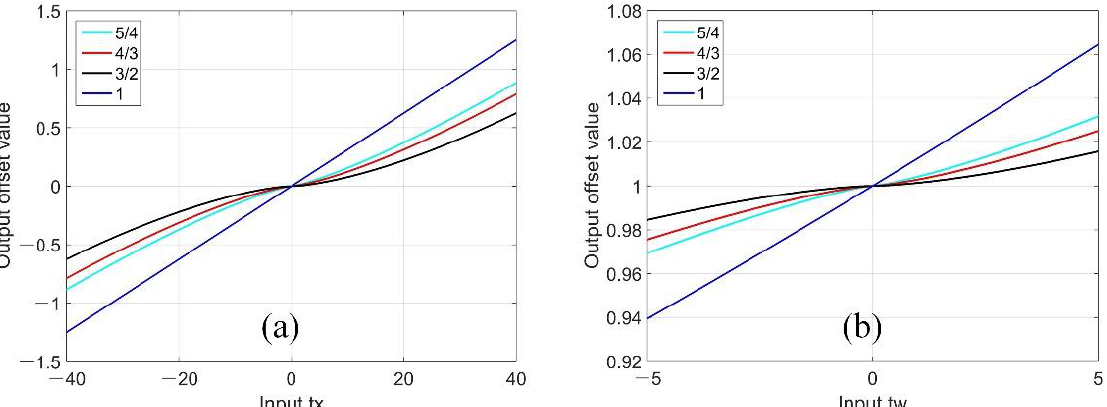
Figure 6. Effects of taking different exponent values in the loss function of bounding box regression, using the fifth stage as an example. ( a ) Input offsets t x vs. bounding box output offset g x − p x at the fifth stage with different exponent values; ( b ) Input offsets t w vs. bounding box output offset ( g w / p w ) at the fifth stage with different exponent values.